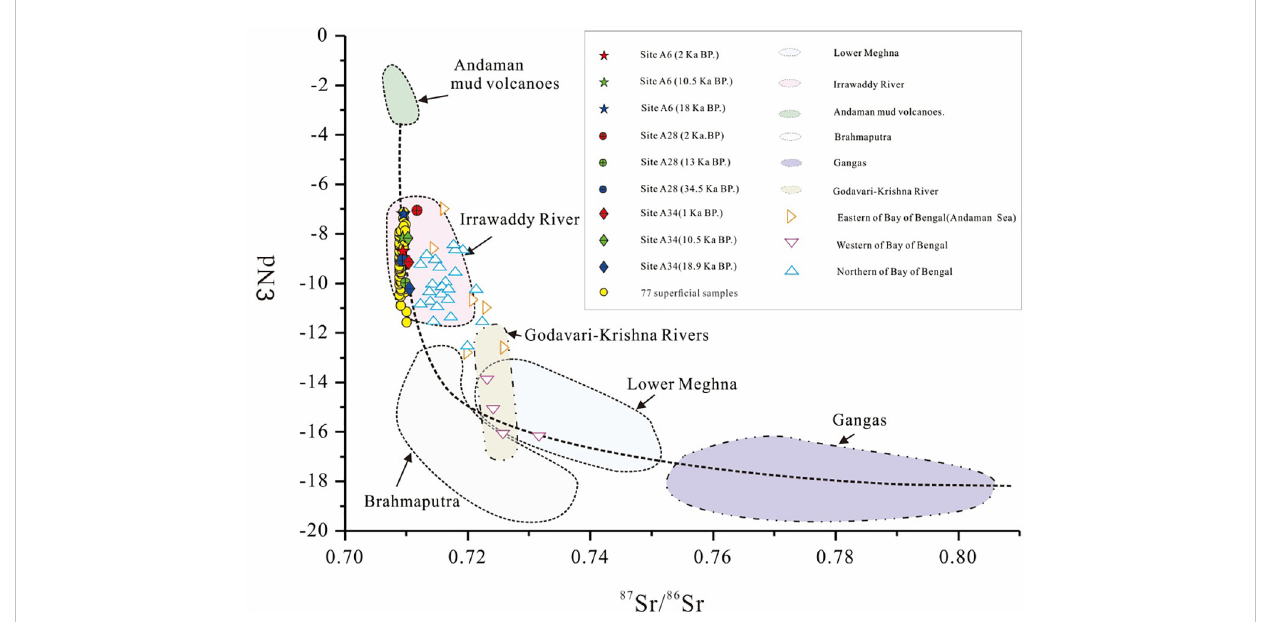
FIGURE 5 Correlation distribution diagram of e Nd and 87 Sr/ 86 Sr in the sediments of the NER and the Bay of Bengal and its surrounding rivers.